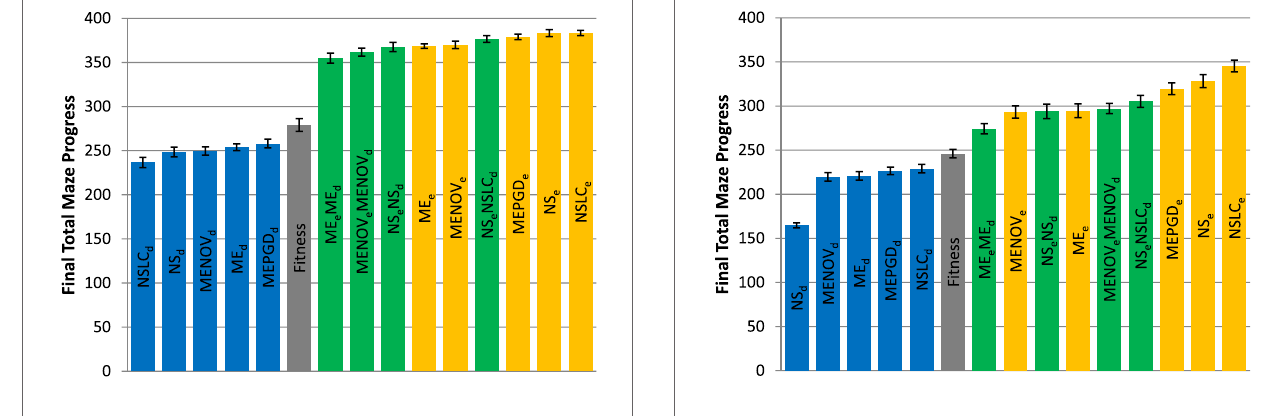
FigUre 4 | Total maze progress (asymmetric gauntlet) . The final total maze progress achieved by each of fifteen treatments ( Table 2 ) after 1,000,000 evaluations on the asymmetric gauntlet is shown (averaged over 20 runs). Bars are color coded according to which BC drives search (see section 6) and error bars represent SE. A maximum possible score of 400 corresponds to solving all four legs of the